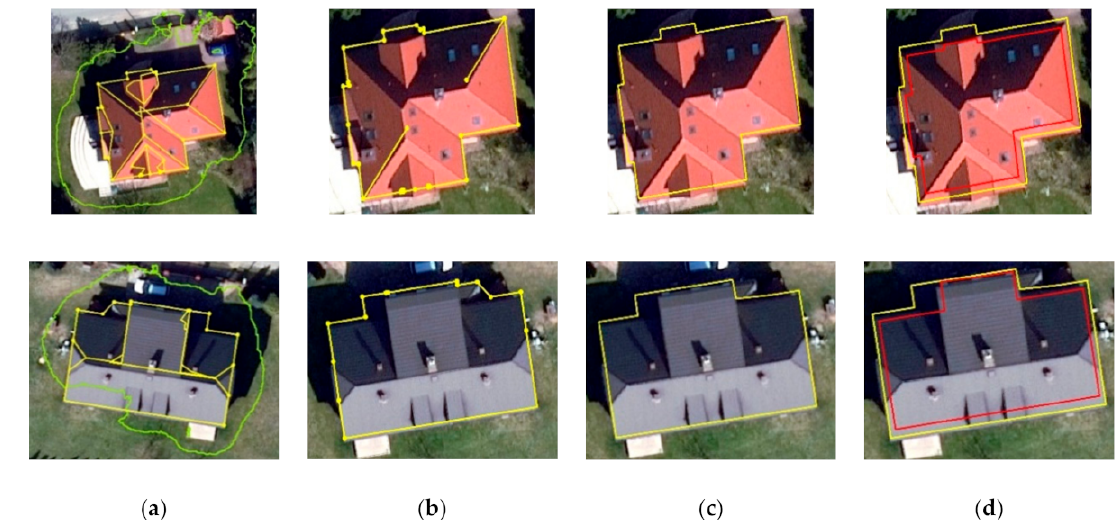
Figure 10. Geoprocessing of buildings rooftop polygons: ( a ) building rooftop patches (yellow lines) within deep learning delineated building footprints (green line); ( b ) building the rooftop outline; ( c ) corrected and simplified rooftop outline; ( d ) shift in building outlines (yellow line) and building footprints from cadastral